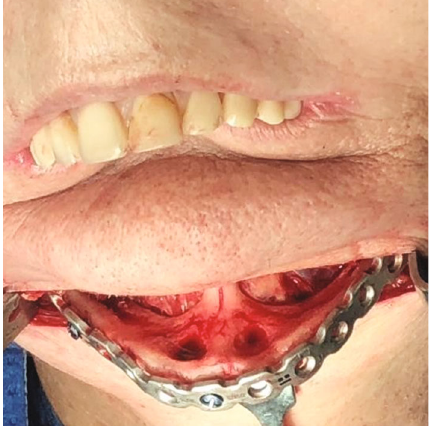
Figure 3: Fixation of the reconstruction